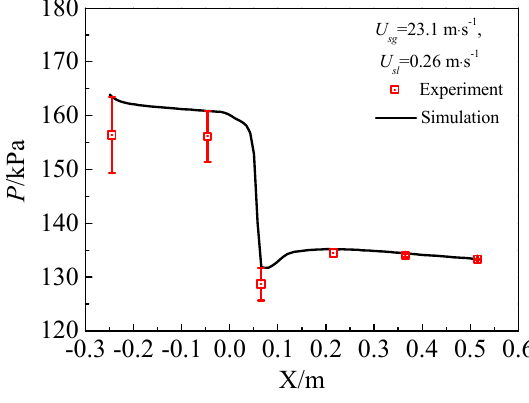
Figure 7. Comparison of simulated wall pressure profile with experimental results. Table 6. Pressure uncertainty of the validation experimental